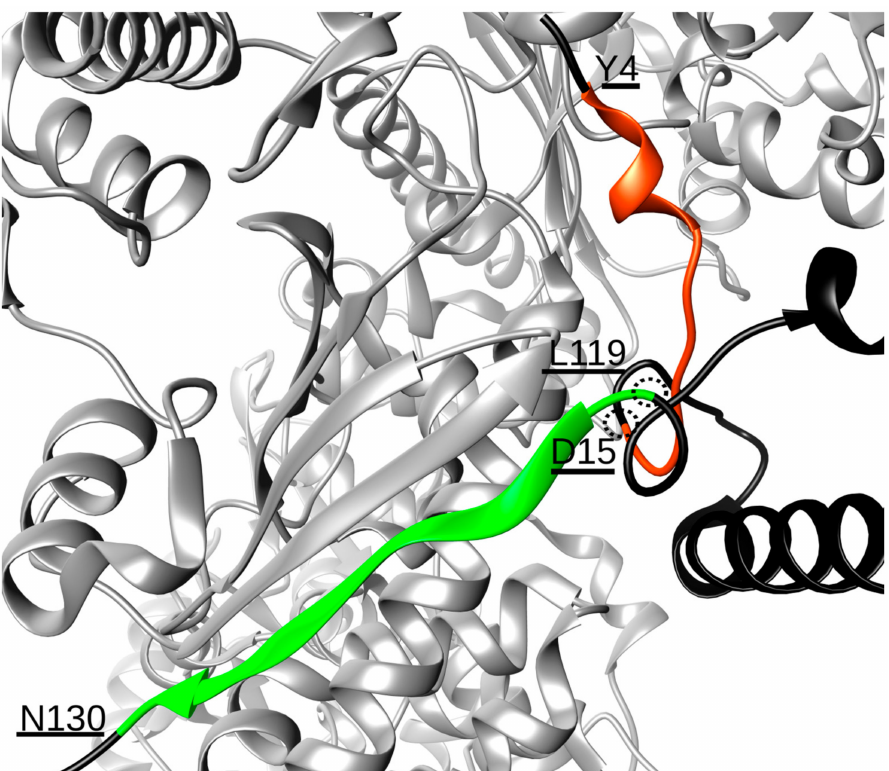
Figure 1. Interaction interface between protomer B of Hsp90 (light grey) and the N-terminal domain of Cdc37 (black). The two stretches of residues of Cdc37 responsible for the binding are highlighted in orange (residues Y4-D15) and green (L119–N130). The structural proximity of residues D15 and L119, which permits the two chains to join, is also underlined. Table 2. Amino acids’ composition of the sequences designed, synthesized and tested. Peptides Sequence Peptide Length Code Purity NYSVWDHIEVSDDLSKDGFSKSMVN